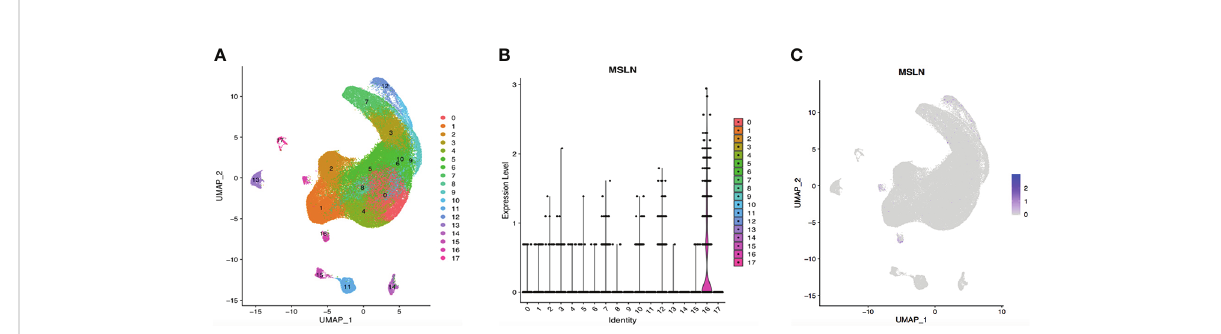
FIGURE 4 ScRNA-seq data analysis showing esophageal cells with low MSLN expression. (A) Cells in the esophagus were categorized into 18 different clusters, and numbered 0 to 17. (B) Violin plot of MSLN expression distribution in these 18 different cell clusters. (C) MSLN expression distribution shown as a scatter